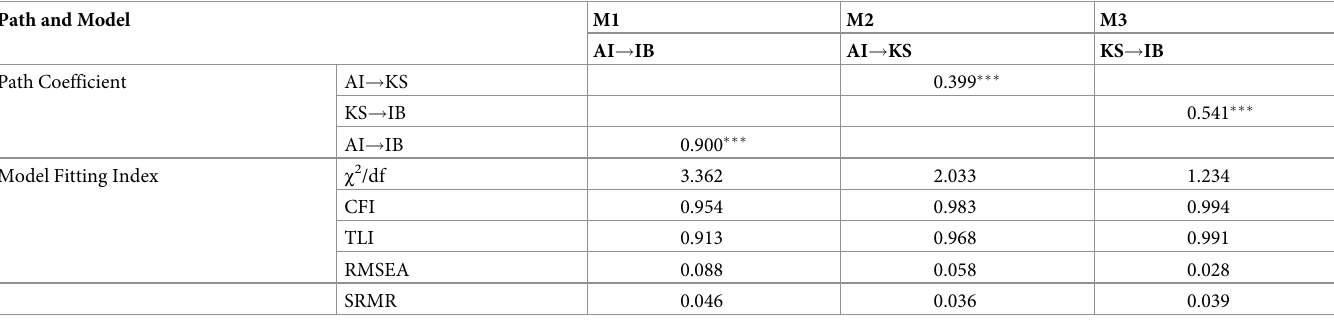
Table 6. Results of main effect analysis. Path and